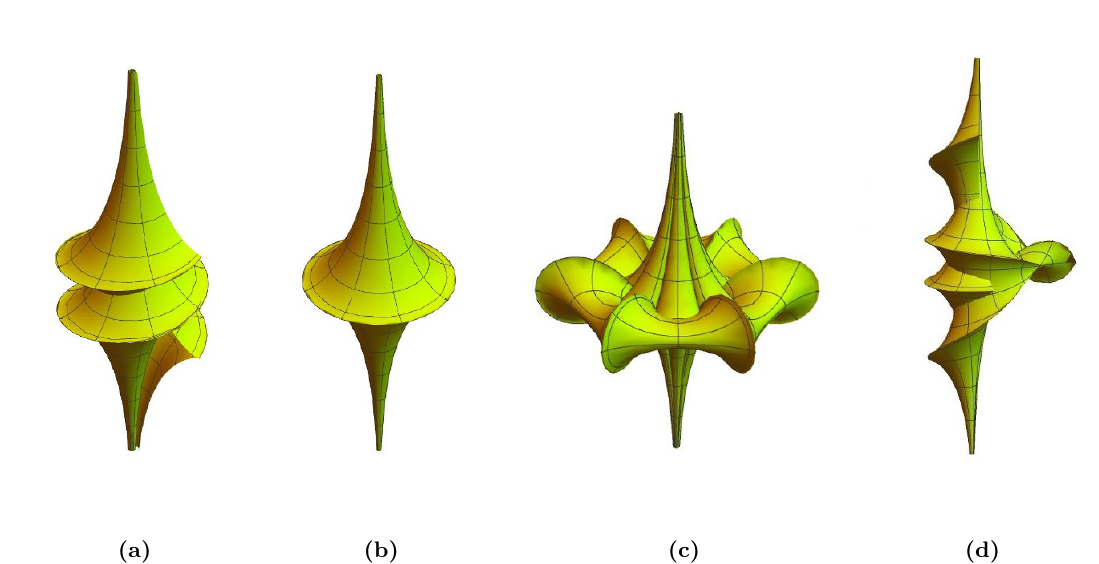
Figure 1. Pseudo-spherical solitonic surfaces associated to kink and breather solutions. Figure 1a represents the Dini surface, corresponding to a moving kink, while in (cid:12)gure 1b the famous Beltrami pseudo-sphere is represented. The latter surface is obtained from Dini’s surface by taking the stationary limit of the kink solution. Figures 1c and 1d correspond to the pseudo-spherical surfaces associated to a stationary breather and to a two-kink solution,